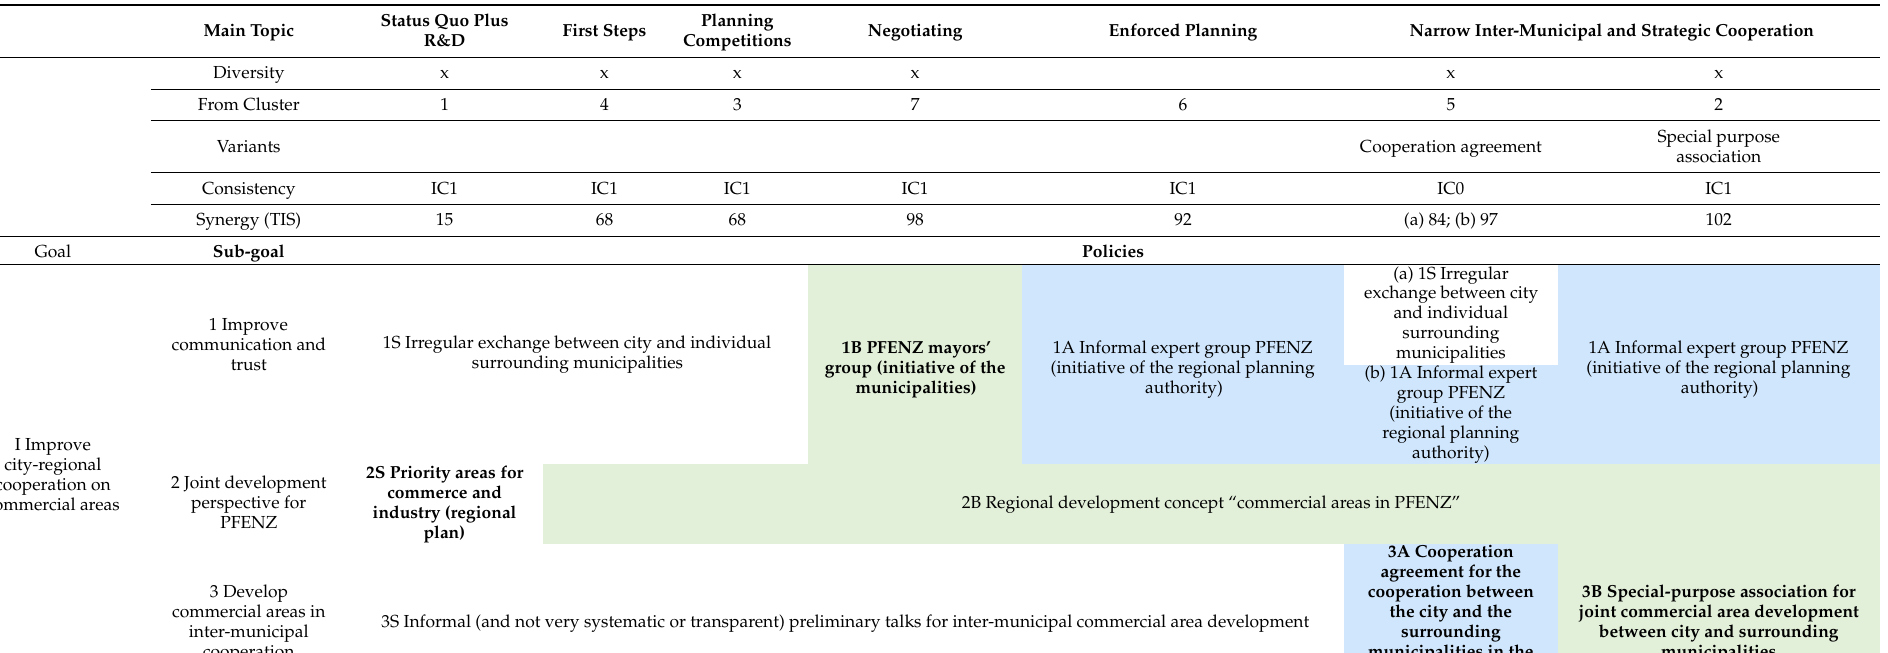
Table 2. Selection of consistent mixes, to be read in columns, status quo white, option A blue , option B green ; unique selling points of each mix within this selection (measures unique to this mix) in bold print